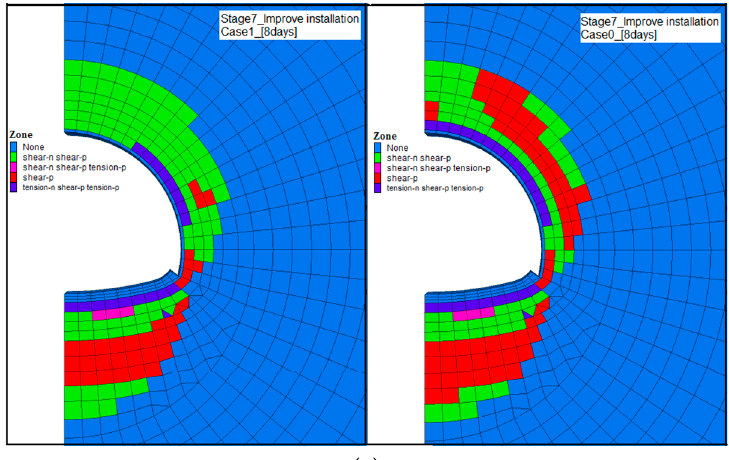
Figure 7. Failure zones of the surrounding rock from stage 1 to stage 6. In this figure, None: no-failure zone; Shear-n: the region failed under shear loading and failure process is still in progress; Shear-p: the region failed under shear loading and failure process is ceased due to lowered amount of shear forces; Tension-n: the region failed under tensile loading and failure process is still in progress; Tension-p: the region failed under tensile loading and failure process is ceased due to lowered amount of tensile forces.